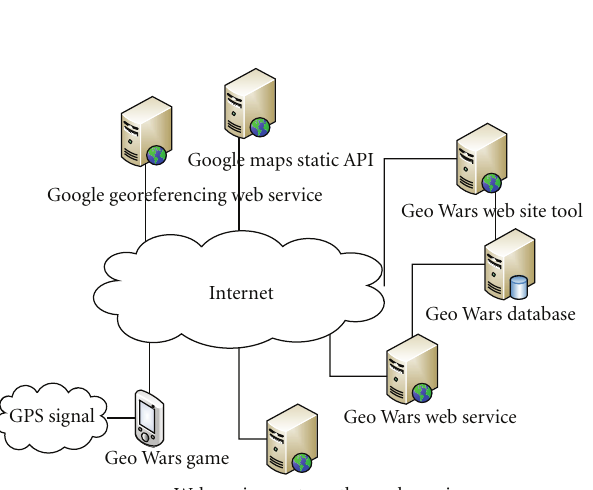
Figure 2: Geo Wars look and feel.